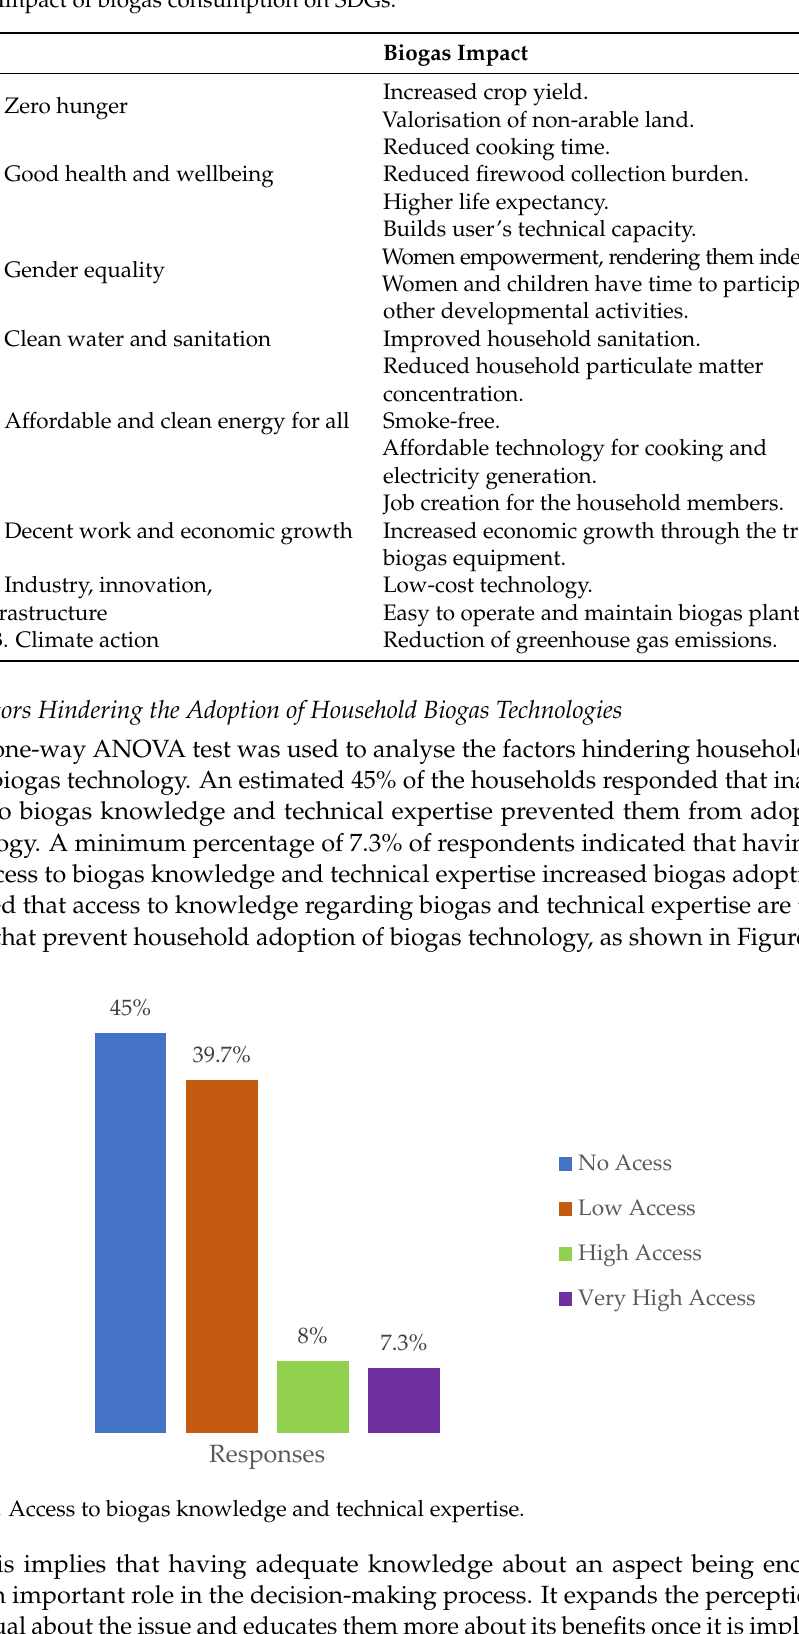
Table 6. Impact of biogas consumption on SDGs.